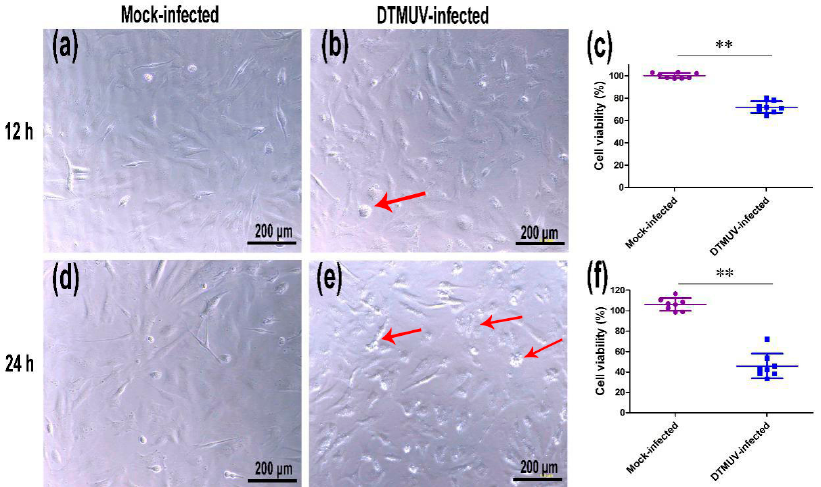
Figure 2. Viability of duck embryo fibroblasts at 12 ( a – c ) and 24 h ( d – f ) after infection with duck Tembusu virus (DTMUV). CPEs (cell shrinkage and rounding, red arrow) were observed in Figure 2b,e. Cell viability is shown as the mean ± SD of eight replicates.** p < 0.01.